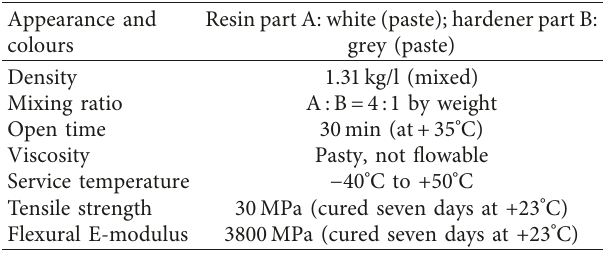
Table 3: Sikadur-330 (two-part epoxy impregnation